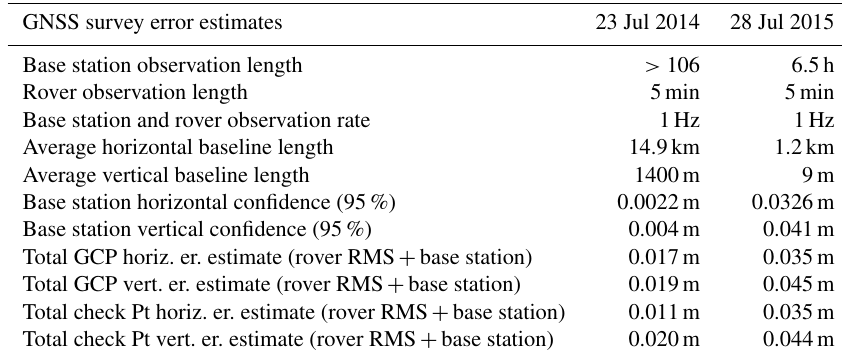
Table 2. Estimated GNSS survey positional errors for use in structure from motion ground control and absolute DEM error analysis. Note: total error estimates include base station and rover error